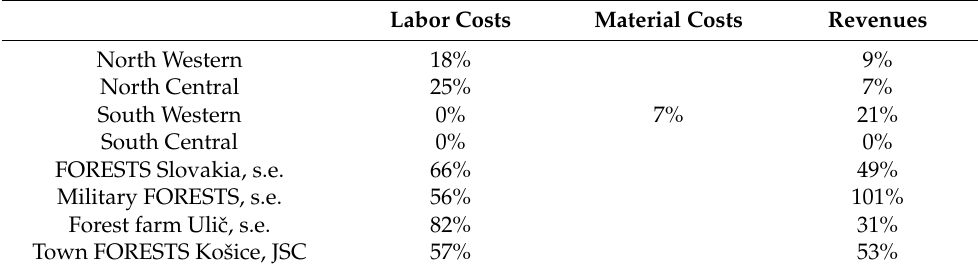
Table 7. The slack-based model results for 2018—input and output slacks. Labor Costs Material Costs Revenues North Western 18%